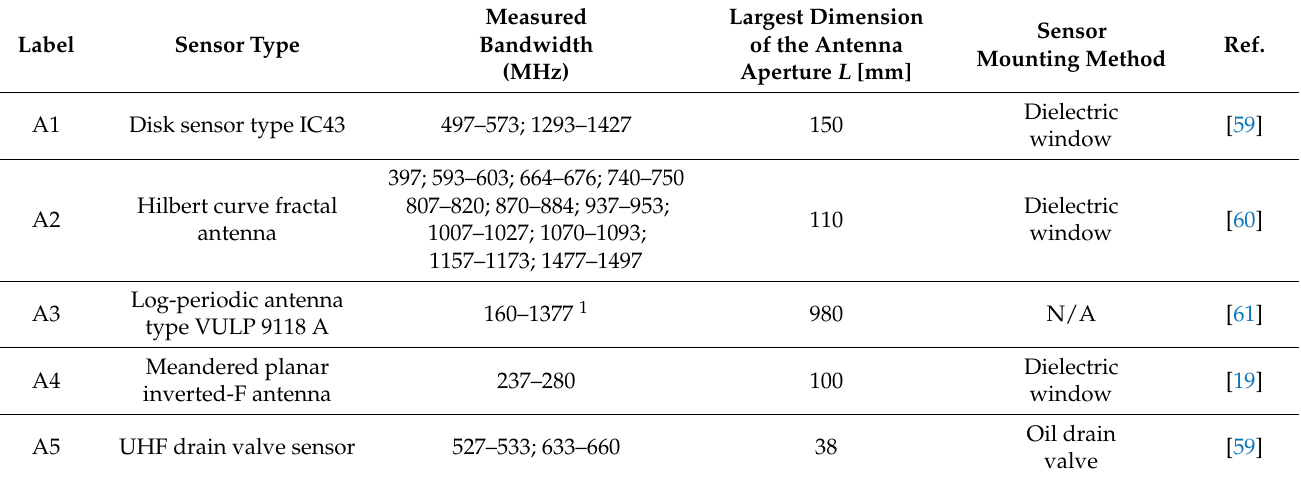
Table 1. Parameters of UHF antennas used in the